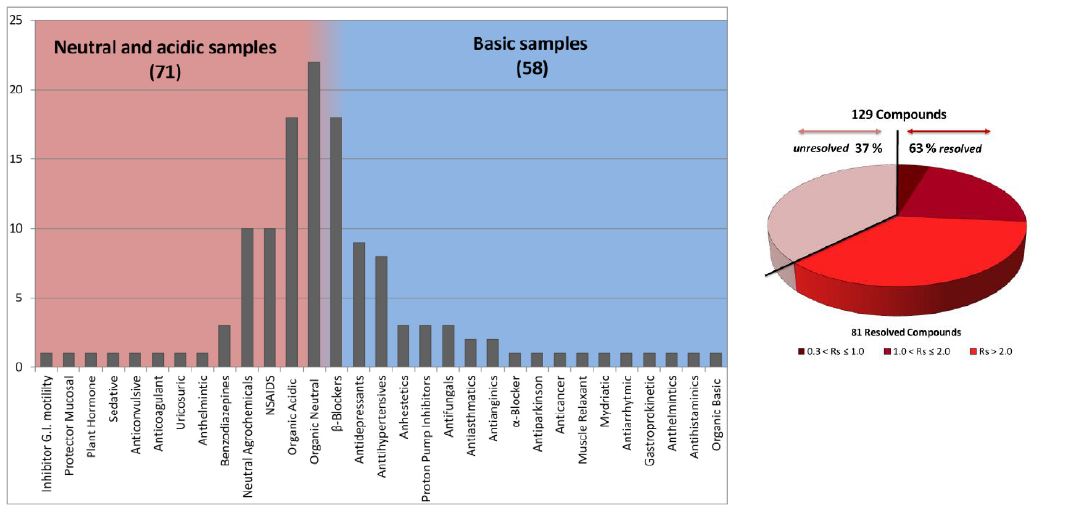
Figure 3. Classification of the different molecules analyzed during fast gradient screening (left); pie chart reporting numerical proportion of resolved enantiomers with different resolution values ( R s = 2(t R ,2 − t R ,1 )/(w 0.5,2 + w 0.5,1 ), being t R retention time and w 0.5 peak width at half height. Modified with permission from ref.